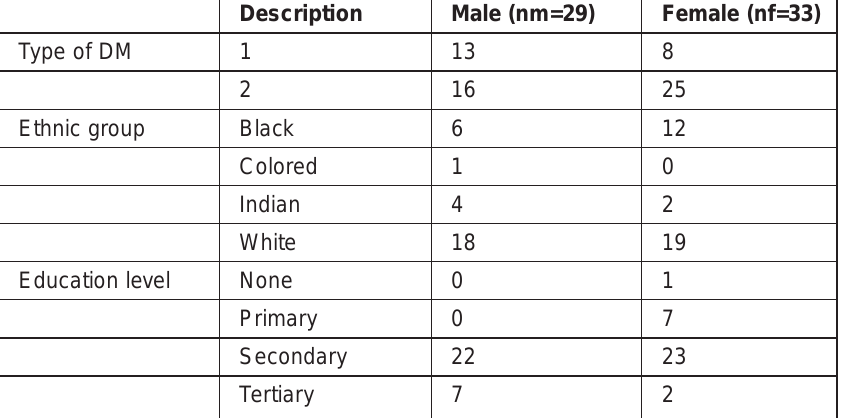
Table 1: Sample description